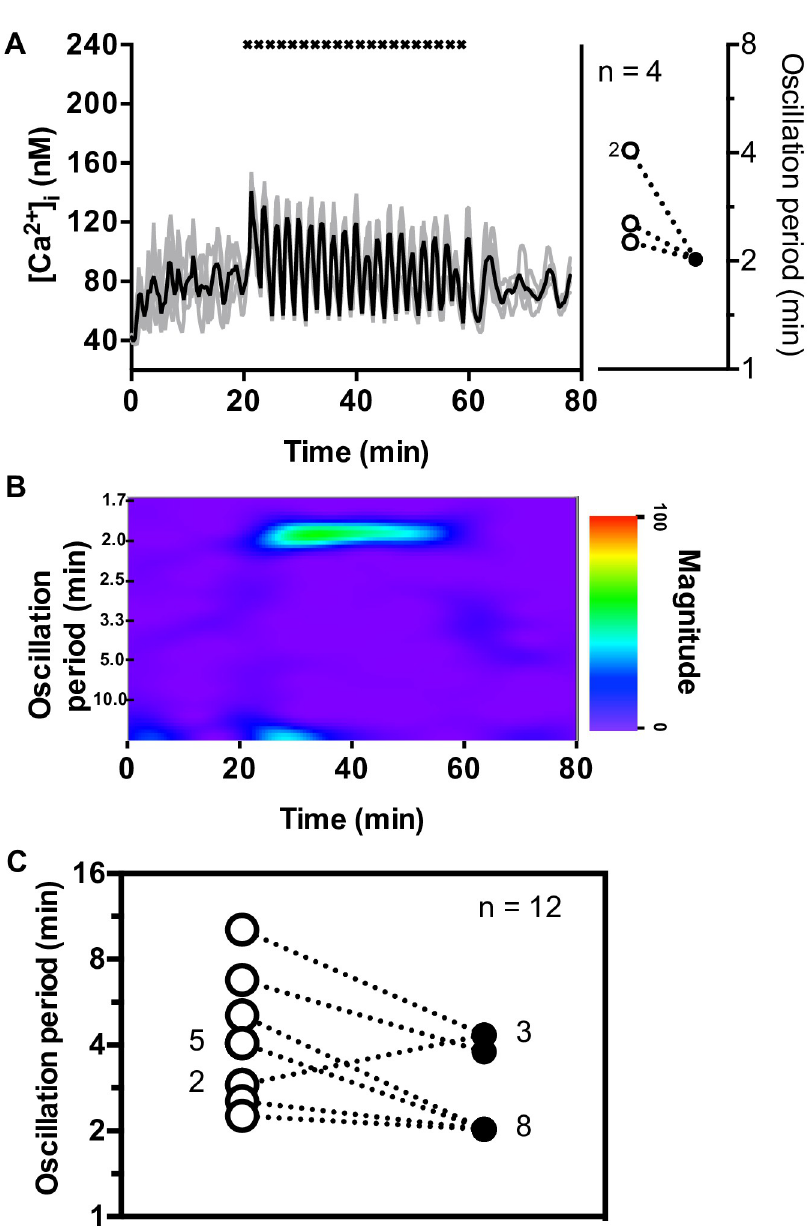
Fig 2. Effect of CCh pulses with rest time of R = 2 min on [Ca 2+ ] i oscillations. (A) The [Ca 2+ ] i traces (gray lines) of four islets and their average (black line) are shown when CCh pulses with rest durations of R = 2 min were applied. The timing of the CCh pulses is shown by the “x” at the top of the figure. The inset shows all four islets had a natural oscillation period between 2 and 4 min (open circles) prior to CCh pulsing, which changed to 2 min upon pulsing (filled circles) indicating 1:1 entrainment. (B) The spectrogram of the average [Ca 2+ ] i from the 4 islets in (A) is shown. As can be seen, while there was no major oscillation period prior to pulsing, a strong band appeared during the 38 min that CCh was applied showing synchronicity by the group at an oscillation period of 2 min. The band at the bottom of the spectrogram at the beginning of the pulsing is an artifact from the data analysis. See S6 and S7 Figs for results from the remaining R = 2 min groups. (C) The oscillation periods of all 12 islets tested are shown prior to (open circles), and during R = 2 min CCh pulsing (filled circles).